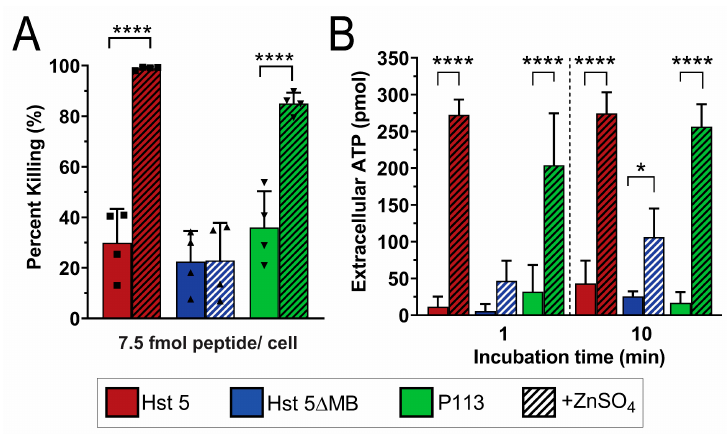
Figure 6. Zinc greatly increases Hst 5 and P113 killing of C. glabrata , and induces almost immediate ATP efflux. C. glabrata Cg931010 cells were used in candidacidal assays and ATP efflux assays. ( A ) For candidacidal assays, cells were incubated for 1 h at 30 ˚ C with Hst 5 (red), Hst 5 Δ MB (blue), and P113 (green) with and without a 1:2 ratio of Zn 2+ to peptides (hatched) at 7.5 fmol peptides/cell in 10 mM sodium phosphate buffer pH 7.4. Squares and triangles indicate individual replicates. ( B ) In bioluminescent ATP efflux assays, cells were treated with 0.88 fmol/cell Hst 5 (red), Hst 5 Δ MB (blue), or P113 (green) in 10 mM sodium phosphate buffer pH 7.4 with or without added Zn 2+ at a one to two peptides ratio (hatched). Cells were removed from samples via centrifugation and aliquots of supernatant were taken at 1 and 10 min time points to measure extracellular ATP by luminescence. Both experiments were repeated on at least three separate days and averaged. Significance of differences in killing and ATP efflux were calculated using one way ANOVA with Sidak’s multiple comparison test. * indicates p ≤ 0.05, **** indicates p ≤ 0.0001